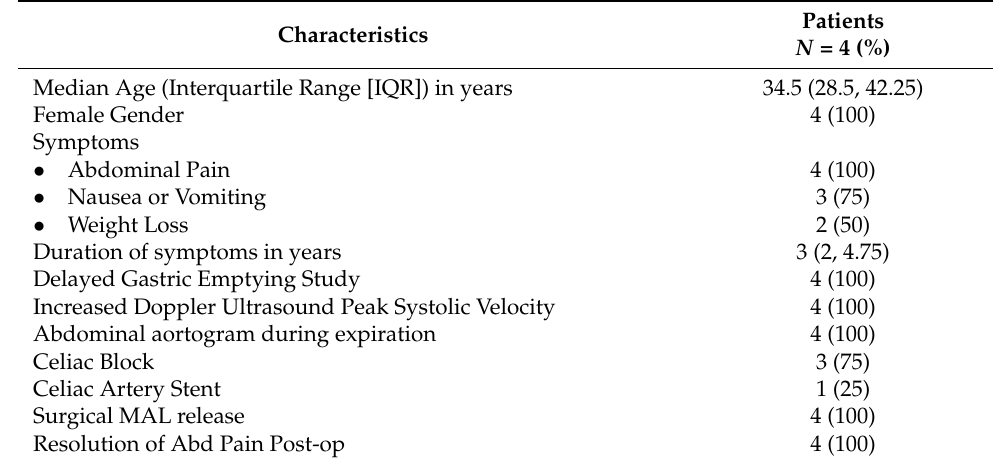
Table 1. Demographics, clinical symptoms, diagnostic studies, treatment, and outcomes of patients with Median Arcuate Ligament Syndrome (MALS).